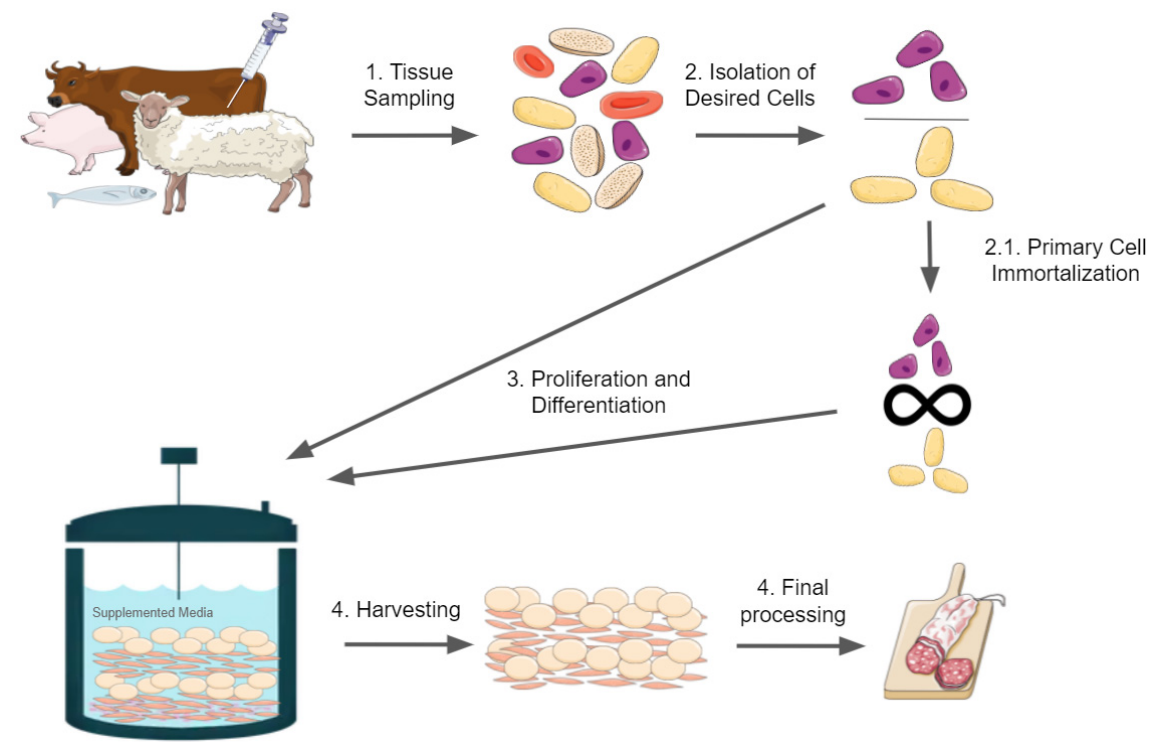
Figure 1. Brief overview of cultured meat production. The figure was constructed with illustrations taken from Servier Medical Art, licensed under a Creative Commons Attribution 3.0 Unported License.